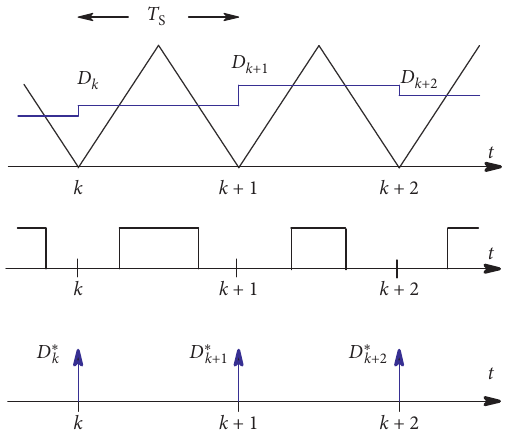
Figure 3: Digital control process to drive VSI using bipolar PWM.